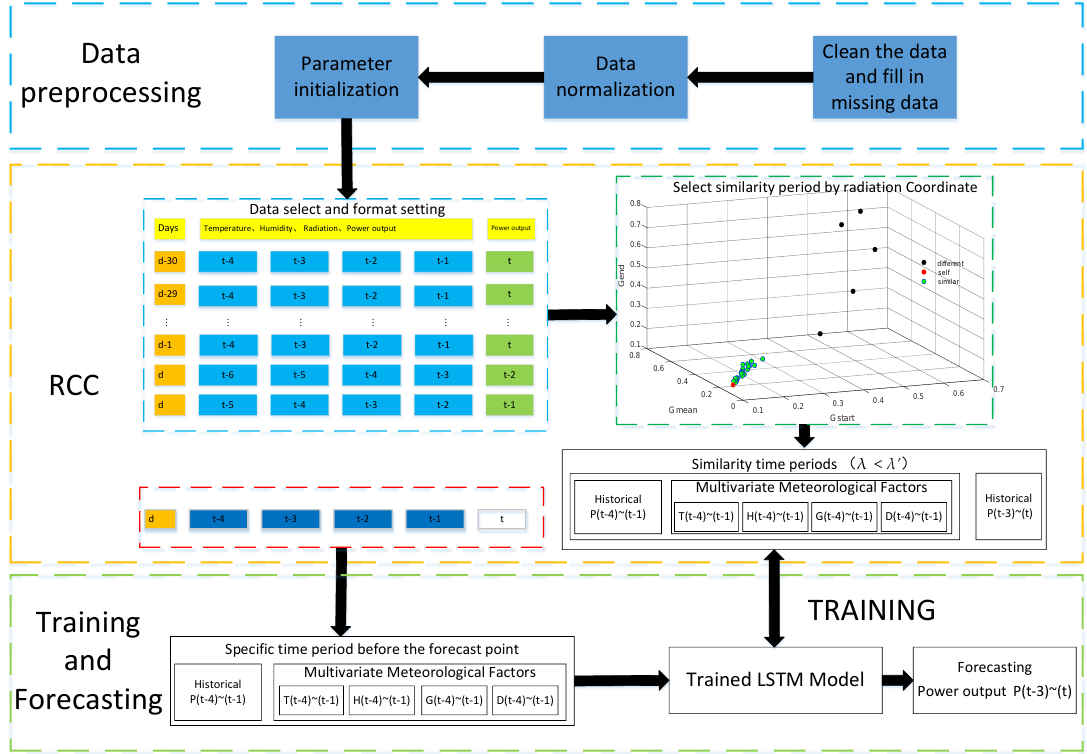
Figure 2. General structure of the RCC-LSTM forecasting model.